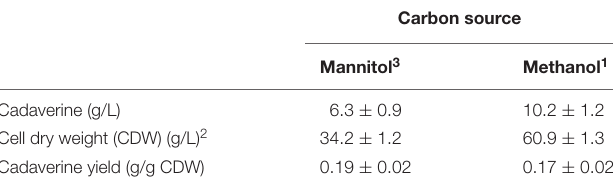
TABLE 5 | Cadaverine production in fed-batch methanol and mannitol fermentations of B. methanolicus MGA3 (pBV2mp-cadA).